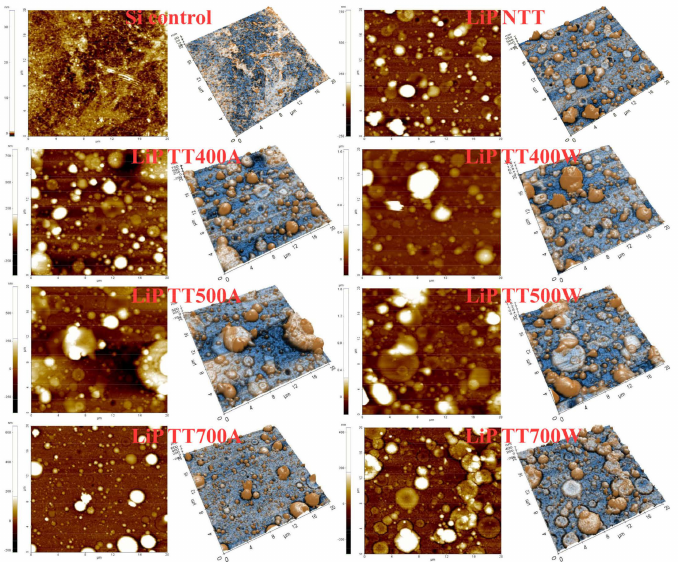
Figure 9. The 2D (classical view mode) and 3D (enhanced color view mode) AFM images of control Si, NTT LiP coatings and of those subjected to post-deposition thermal treatments (at different temperatures), in air (A–left columns) and water-vapor (W–right columns)